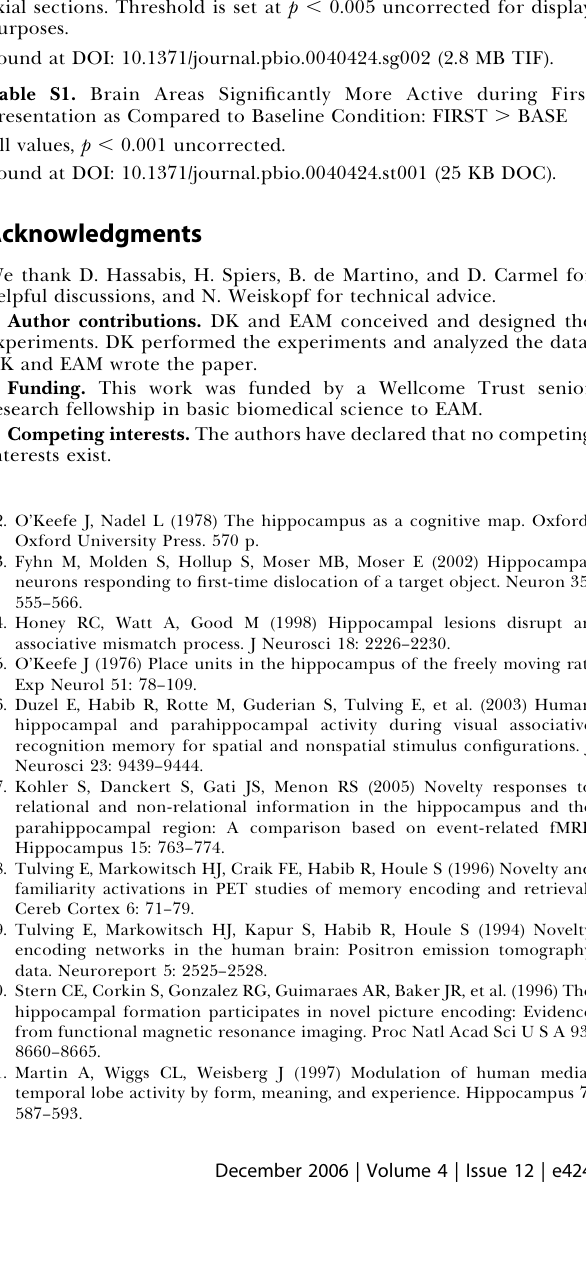
Figure S2. Event-Related Analysis with Trial Onset Set at Critical Third Object: Main Effect of Sequence Type (S half . S rep ) Results of comparison of S half and S rep conditions (S half . S rep , collapsed across object-context factor) in analysis in which trial onset was set at the critical third object in the sequence in which an associative mismatch occurs in the S half condition (see Materials and Methods). ‘‘ Glass brain ’’ figures are displayed above. Activations shown on the averaged structural MRI scan of the 17 participants (displayed below). R, right side of the brain. The color bar indicates the t-statistic associated with each voxel and the Z -score equivalent. Activation in left hippocampus ( x, y, z ¼(cid:2) 27, (cid:2) 15, (cid:2) 18; z ¼ 3.96) evident in sagittal and coronal sections. Activation in right entorhinal/ perirhinal ( x, y, z ¼ 21, 9, (cid:2) 30; z ¼ 3.94) also evident on coronal and axial sections. Threshold is set at p , 0.005 uncorrected for display purposes. Found at DOI: 10.1371/journal.pbio.0040424.sg002 (2.8 MB TIF). Table S1. Brain Areas Significantly More Active during First Presentation as Compared to Baseline Condition: FIRST . BASE All values, p , 0.001 uncorrected. Found at DOI: 10.1371/journal.pbio.0040424.st001 (25 KB